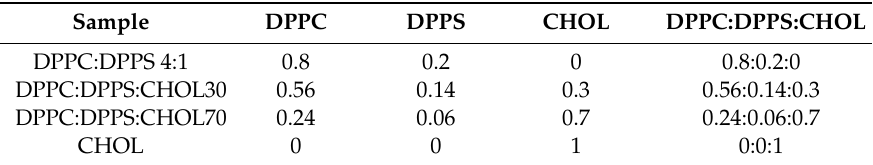
Table 1. Composition of the lipid mixtures